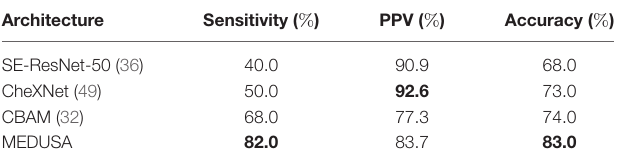
TABLE 4 | Sensitivity, positive predictive value (PPV), and accuracy of the proposed network (multi-scale encoder-decoder self-attention, MEDUSA) on the test data from the RSNA Pneumonia dataset in comparison to other networks.